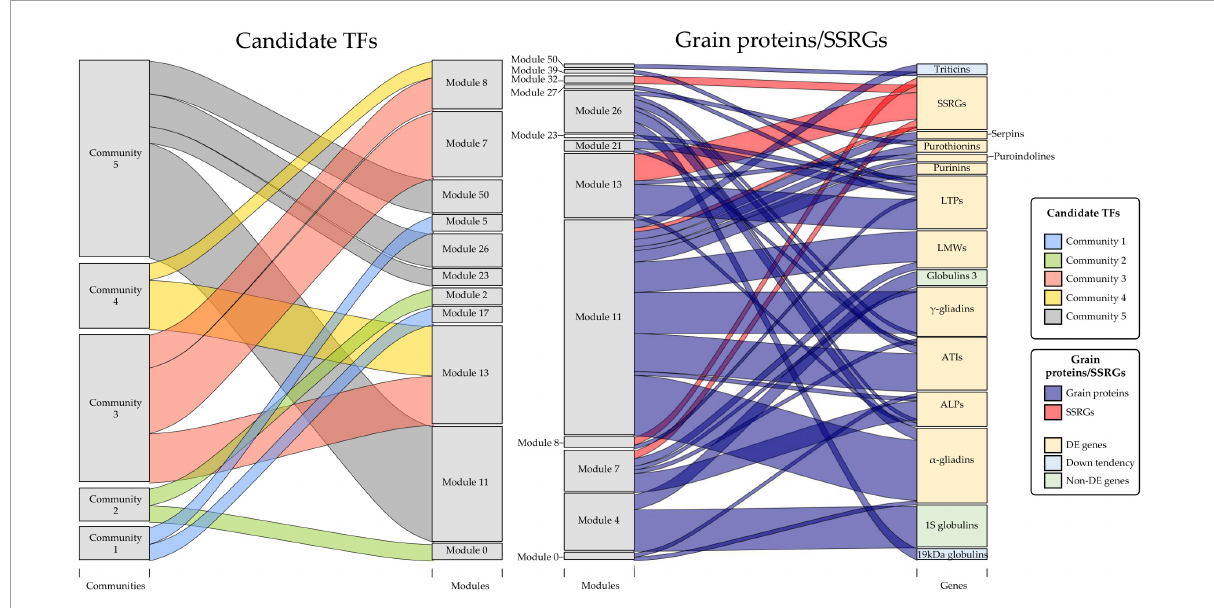
FIGURE6 Relationships between communities of candidate transcription factors (TFs) and modules of Weighted Gene Co-expression Network Analysis (WGCNA) grain co-expression network (left), and between these modules and grain proteins/starch synthesis-related genes (SSRGs) (right). The size of the gray boxes indicates the number of genes contained in each category. All the grain protein genes and SSRGs used for representation were differentially expressed (DE) in our RNA-seq analysis. In the case of grain protein genes, the globulin ones non-DE were included for discussion purposes. Down tendency: genes with non-significant lower expression in E82, except for one DE gene encoding 19 kDa